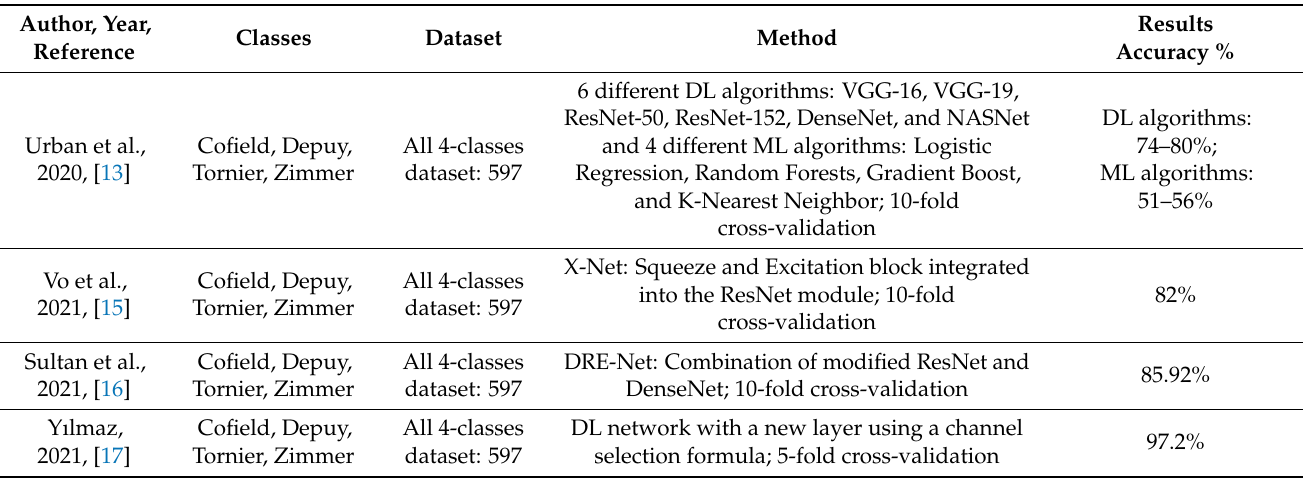
Table 9. Overview of studies conducted using the same